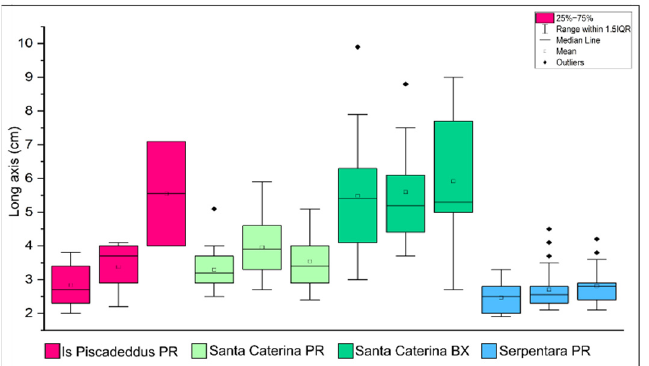
Figure 4. Boxplots of the dimension of the long axis of measured rhodoliths. PR is for praline, BX is for boxwork. Is Piscadeddus in pink, Santa Caterina PR in light green, Santa Caterina BX in green, and Serpentara PR in blue.